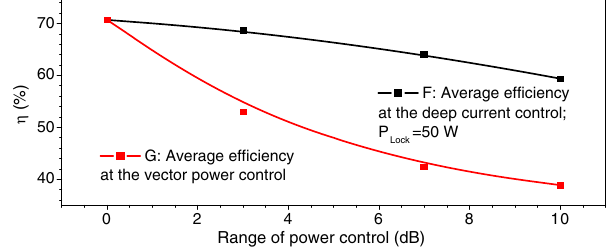
FIG. 7. Averaged magnetron efficiency vs range of power control for various methods of control. Curve F shows the average efficiency of the 1.2 kW magnetron driven by the injected resonant signal of − 10 dB and measured at deep magnetron current control. Curve G shows the average efficiency of 1 kW magnetrons with vector power control [12,13].